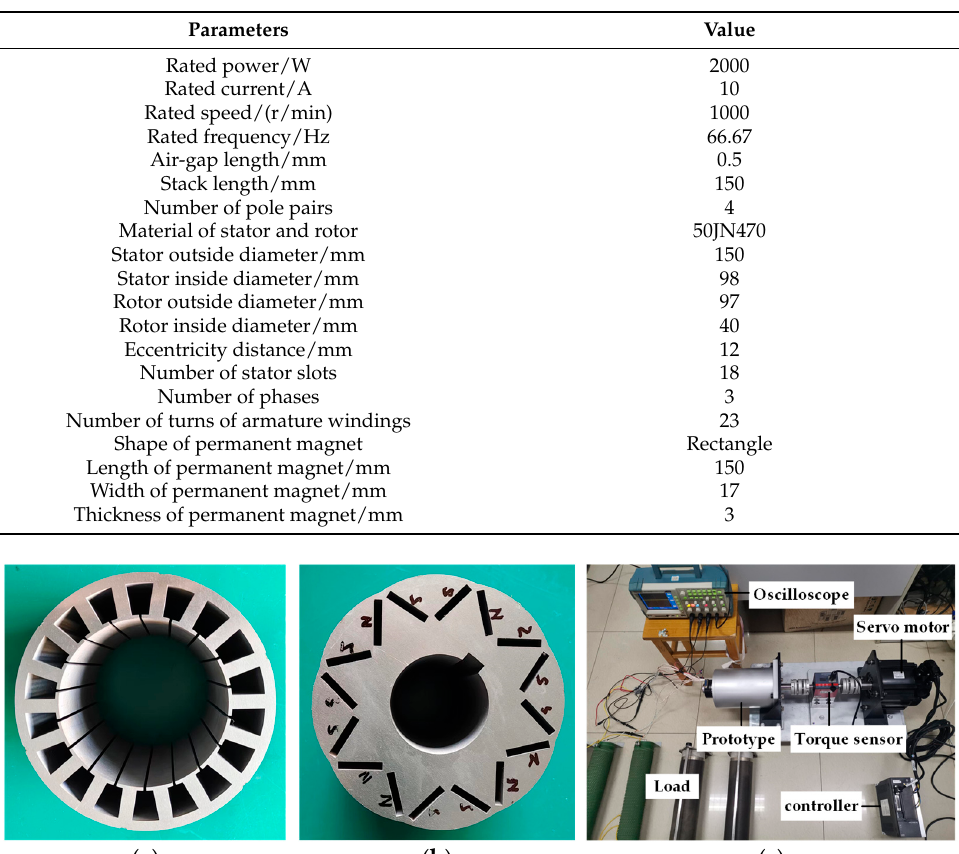
Table 3. Main performance index and structural parameters of AGE-IPM machine.